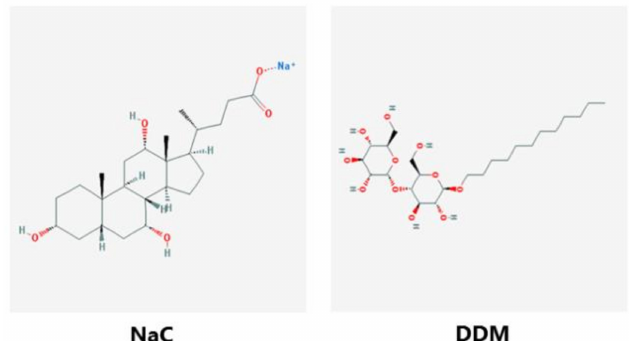
Figure 1. The chemical structure of NaC and DDM. (The images were downloaded from the PubMed Open Chemistry Data Base (https://www.ncbi.nlm.nih.gov/Structure/pdb/2MLT)).